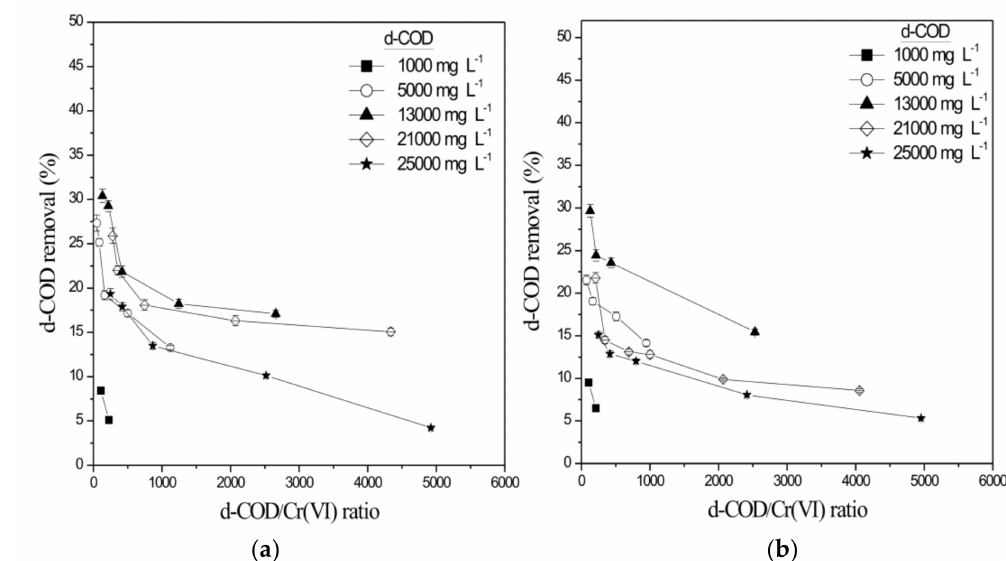
Figure 7. Effect of (initial d-COD)/(initial Cr(VI)) ratio on d-COD removal in the Cr-WE-filter for various initial d-COD concentrations under SBR mode with recirculation rates of: ( a ) 0.5 L min − 1 and ( b ) 1.0 L min − 1